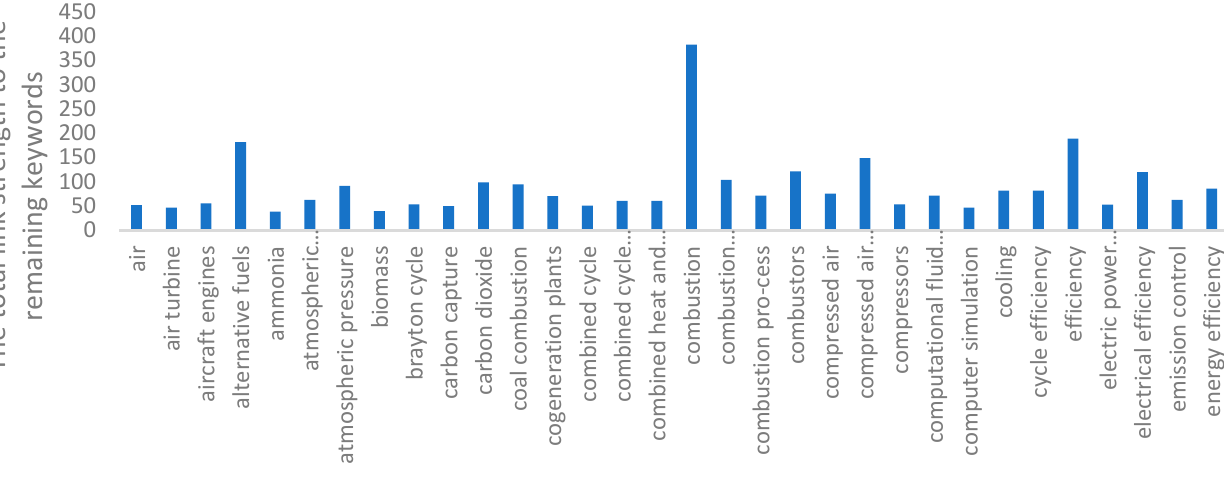
Figure 13. The network map of the keywords related to “humidified gas turbines”. The size of the circle of a keyword is determined by the weight of the keyword com- pared to the other keywords. The higher the weight of the keyword, the larger the label and the circle of the keyword. The color of an item is determined by the cluster to which the item belongs. The distance between two keywords in the visualization approximately indicates the relatedness of the keywords. Figure 14 shows the link strengths of the key- words to each.